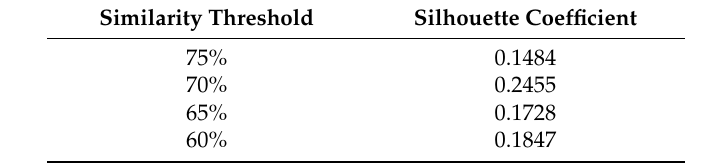
Table 4. Silhouette coefficient of experimental region a under different thresholds.